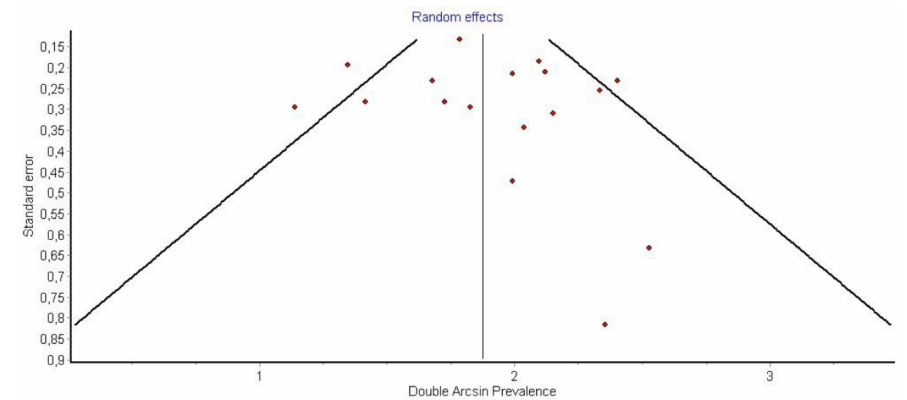
Figure 3. Funnel plot P1.